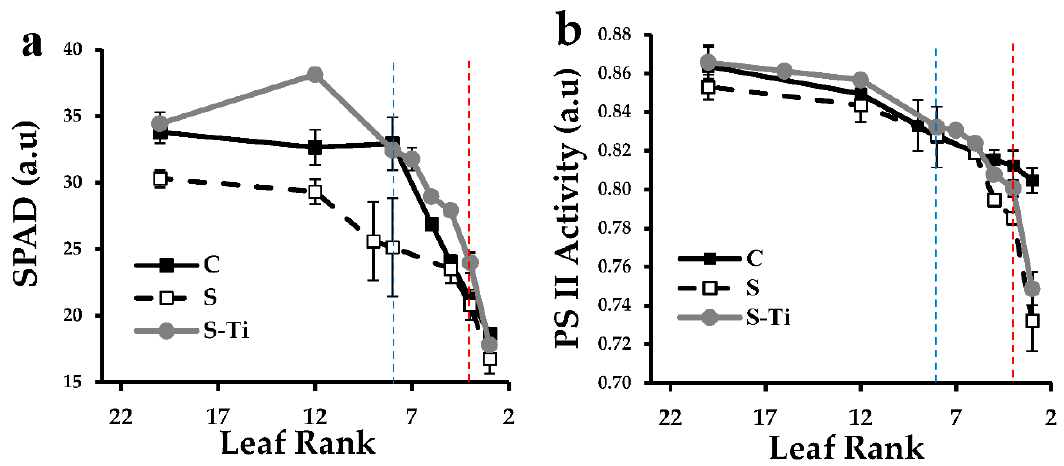
Figure 2. ( a ) SPAD among the canopy of the plants for the different treatments at the second stage. ( b ) PSII activity among the canopy of the plants for the different treatments at the second stage. Dotted lines indicate the 8th (blue) and 4th (red) leaf ranks. Bars represent standard deviation.